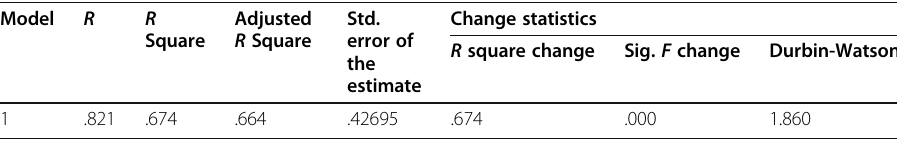
Table 3 Regression analysis